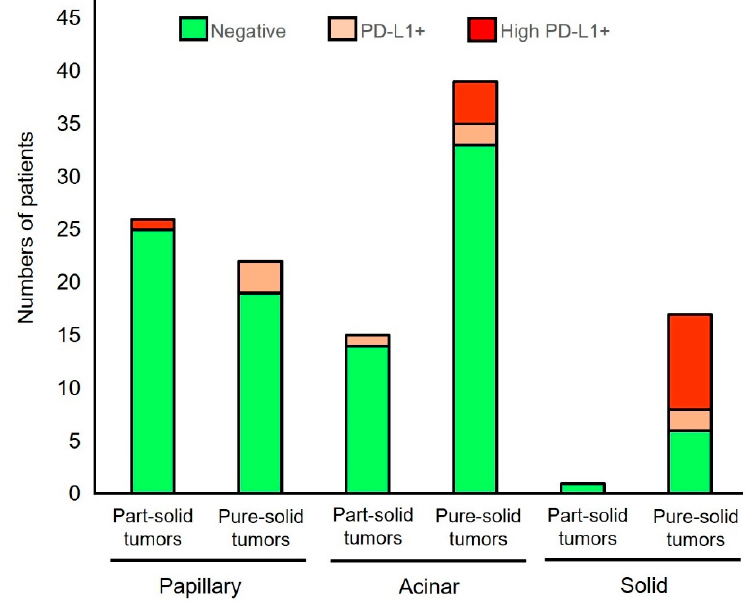
Figure 1. The correlation between PD-L1 positivity and histological subtypes in part-solid LADs and pure-solid LADs. PD-L1 + indicates tumors with PD-L1 membrane staining in 1–49% of tumor cells and high PD-L1 + indicates those with PD-L1 membrane staining in ≥ 50% of tumor cells.